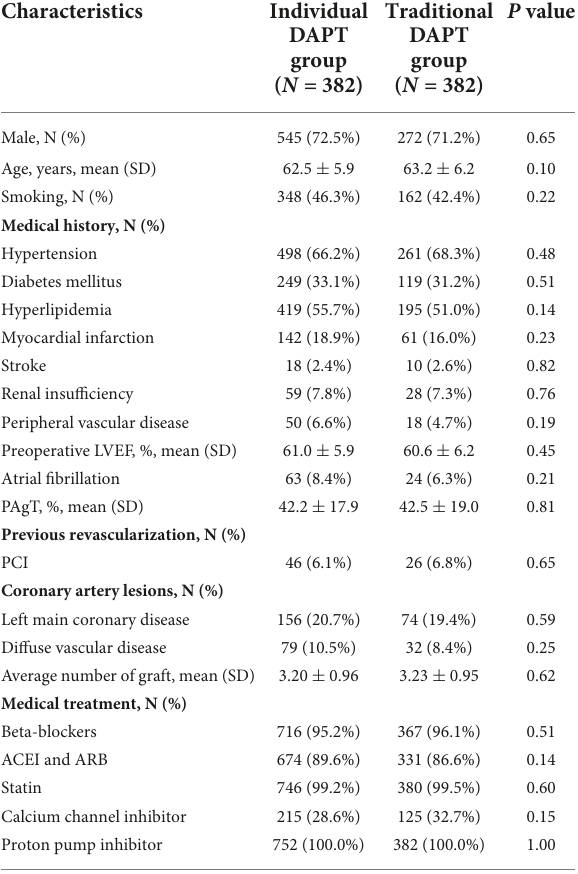
TABLE 1 Demographics and characteristics of the study population.